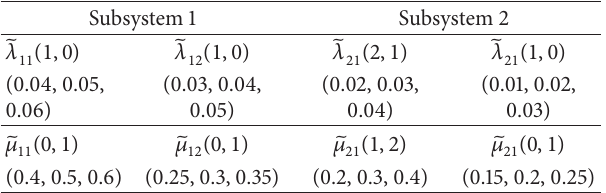
Table 1: The fuzzy transition rates for the components of each subsystem.